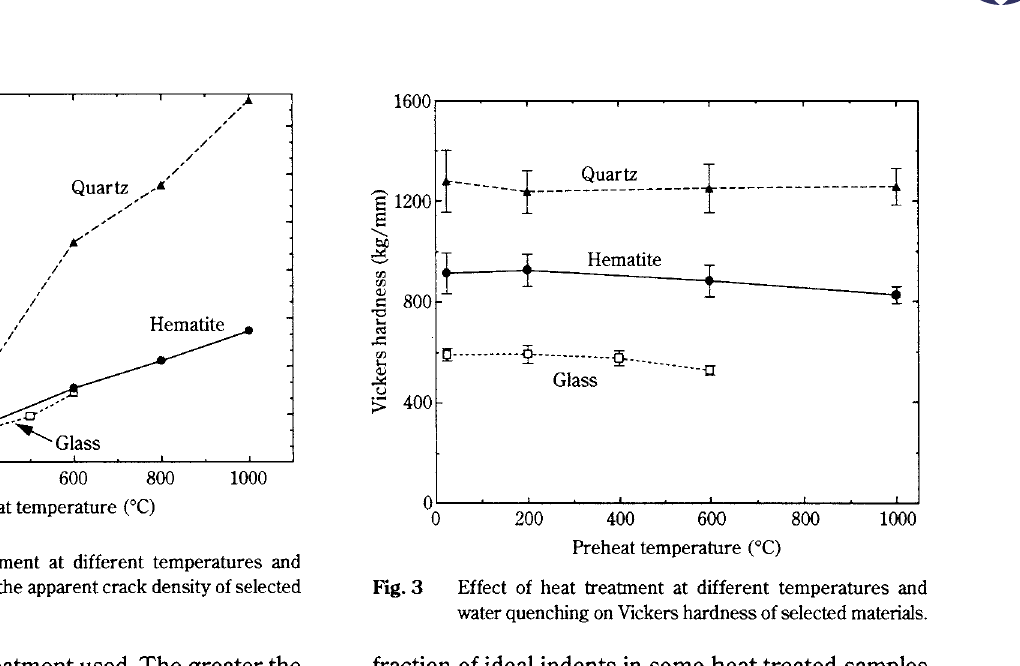
Effect of heat treatment at different temperatures and water quenching on the apparent crack density of selected materials.